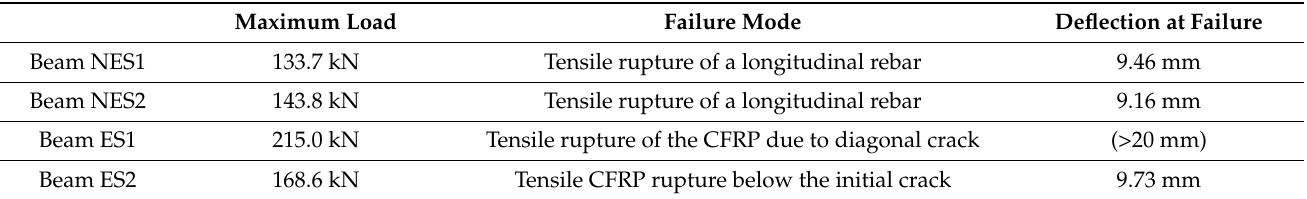
Figure 8. Load versus mid-span deflection behavior of samples under monotonic bending. Table 5. Experimental results of the ultimate monotonic bending tests.